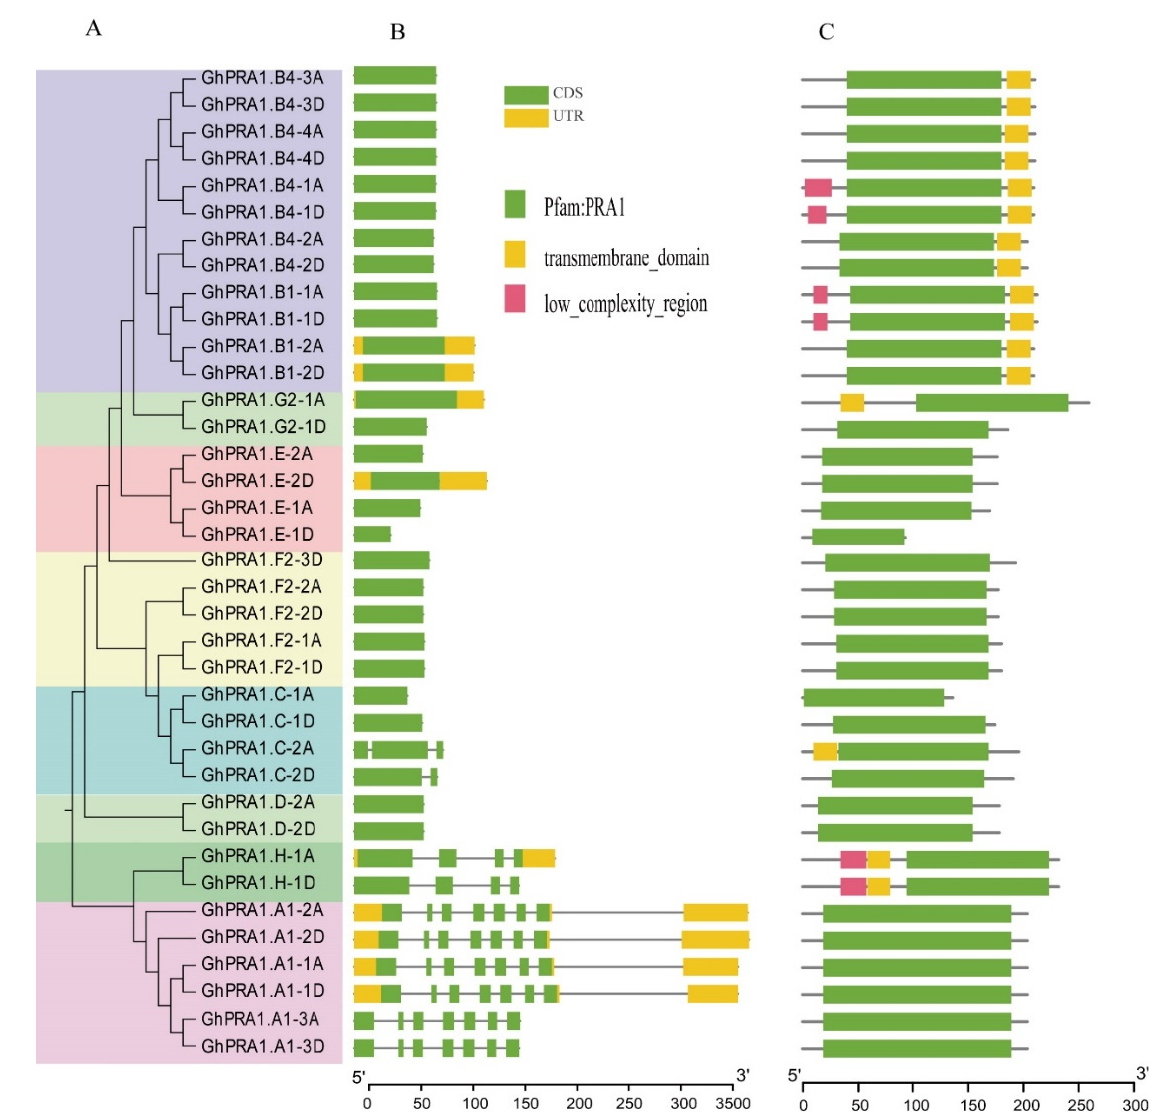
Figure 2. Gene structures and conserved domains in GhPRA1 family members. ( A ) Phylogenetic tree of GhPRA1 proteins. ( B ) The organization of exons and introns in GhPRA1 genes. ( C ) Conserved domains in GhPRA1 proteins.